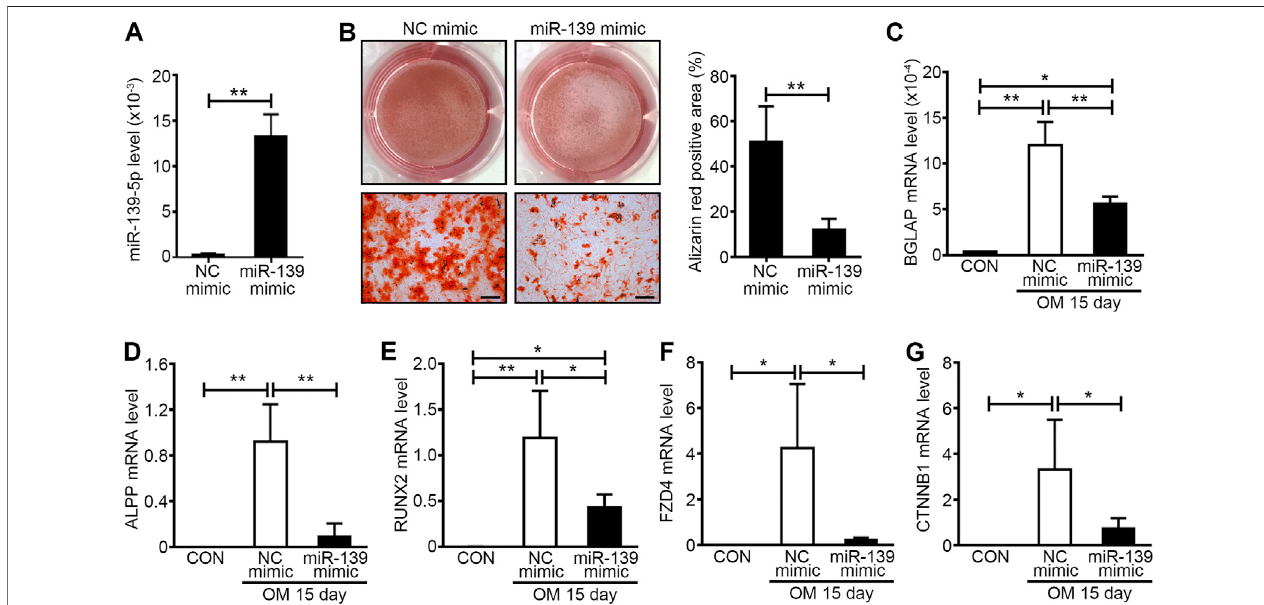
FIGURE 5 | miR-139-5p overexpression could inhibit the osteogenic differentiation of VICs. (A) The expression levels of miR-139-5p in negative control (NC) mimics and miR-139-5p mimics (miR-139 mimic) transfected VICs were accessed by qRT-PCR and normalized with U6 ( n (cid:2) 4 samples from independent wells in each group). Unpaired Student ’ s t -test, ** p < 0.01. (B) Alizarin red staining was used to access the matrix calcium deposition in NC mimics and miR-139-5p mimics transfected VICs at 15 days after OM induction and the right graph was the percentage of Alizarin red positive area per fi eld (n (cid:2) 3 wells in each group and three to four fi elds per well were counted, the scale bar (cid:2) 200 μ m).Unpaired Student ’ s t -test, ** p < 0.01. (C – E) Theexpression levels of BGLAP (C) , ALPP (D) and RUNX2 (E) in NC mimics and miR-139-5p mimics transfected VICs were accessed by qRT-PCR and normalized with GAPDH ( n (cid:2) 4 samples from independent wells in each group). (F,G) The expression levels of FZD4 (F) and CTNNB1 (G) in NC mimics and miR-139-5p mimics transfected VICs were accessed by qRT-PCR and normalized with GAPDH ( n (cid:2) 4 samples from independent wells in each group). One-way ANOVA, * p < 0.05, ** p <